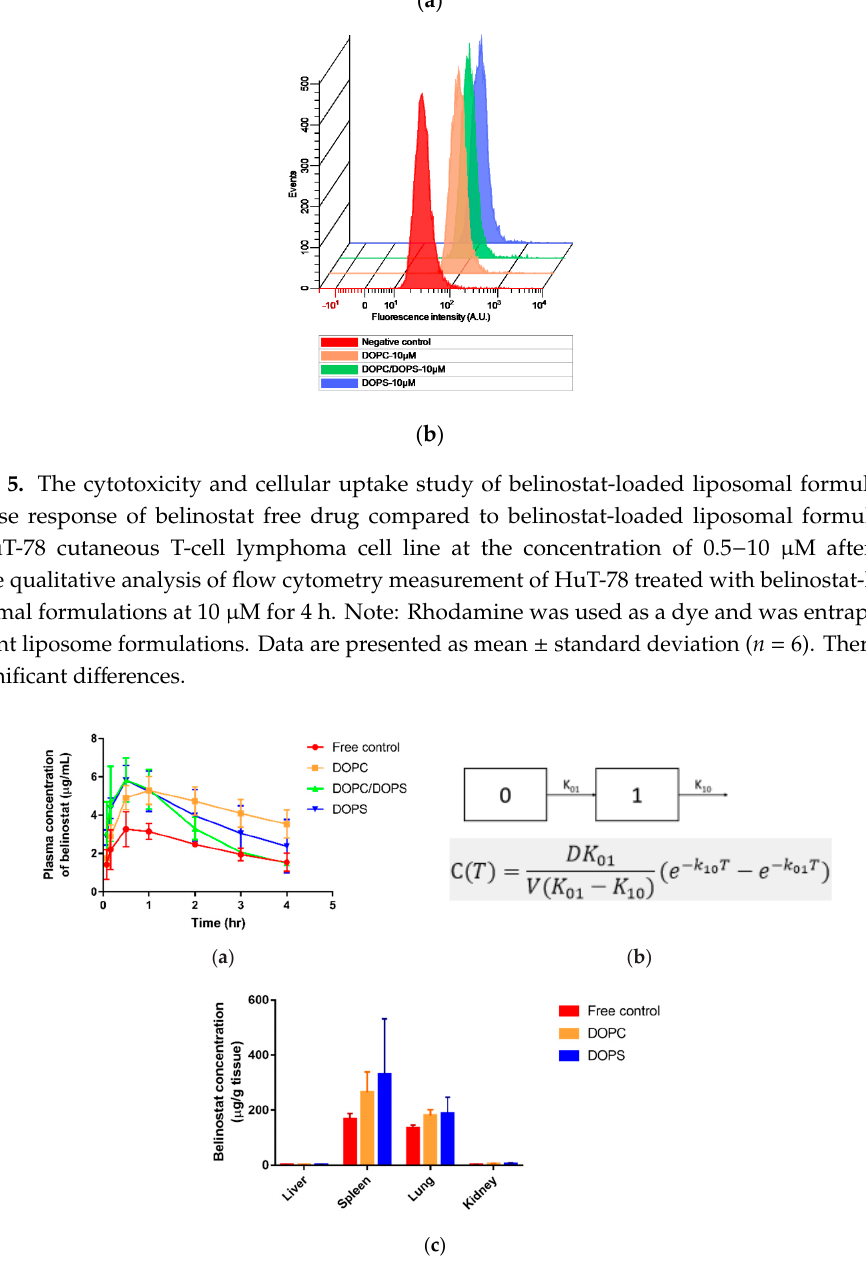
Figure 6. In vivo pharmacokinetics behavior. ( a ) Plasma concentration vs. time profile of belinostat free drug and belinostat-loaded liposomal groups with DOPC, DOPS, and DOPC/DOPS mixture groups after subcutaneous administration in Balb/c mice as a single dose of 0.333 mg/g. ( b ) The one-compartment pharmacokinetics model was fitted with first-order input and output, no lag time and estimated relative equation. ( c ) In vivo biodistribution of belinostat free drug and belinostat-loaded liposomal formulations. Data are presented as mean ± standard deviation ( n = 3).